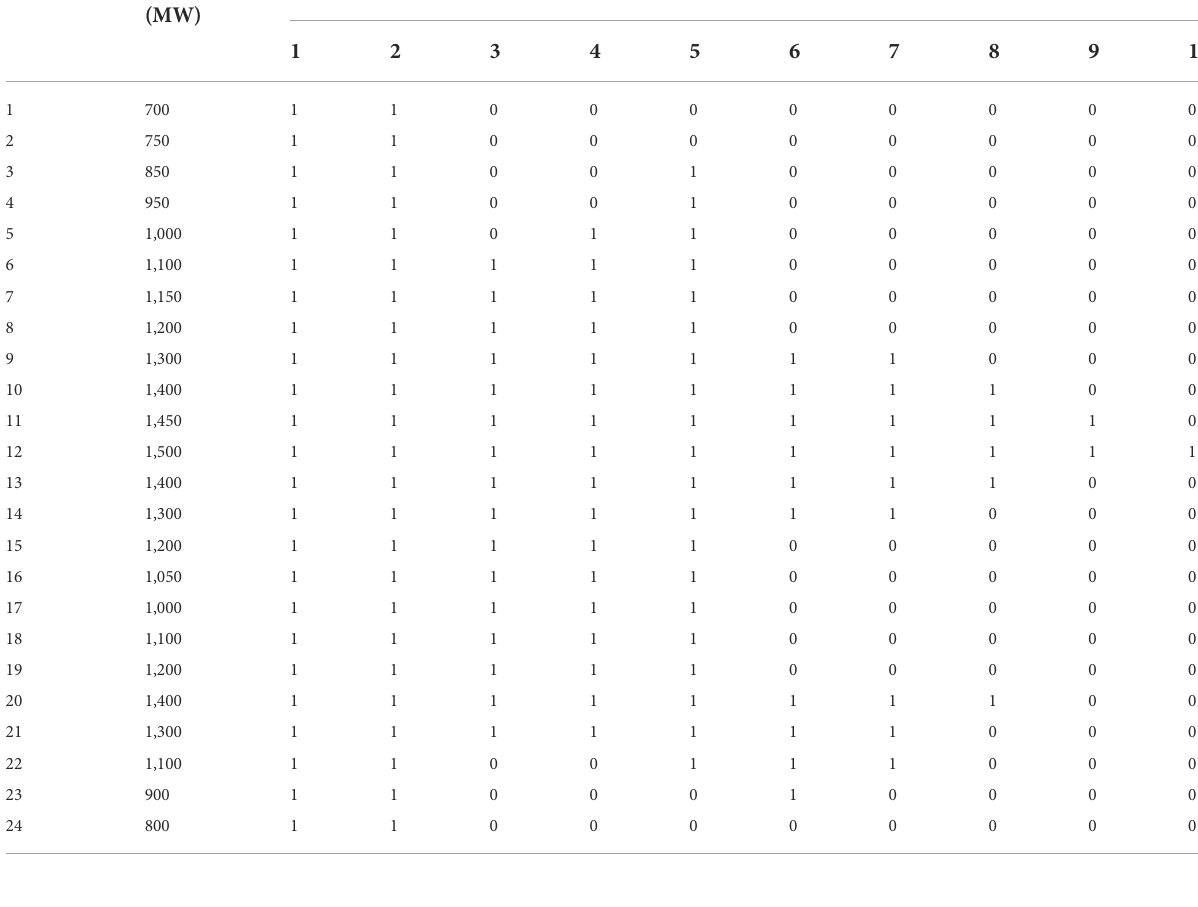
TABLE 2 Unit Commitment for 10-unit